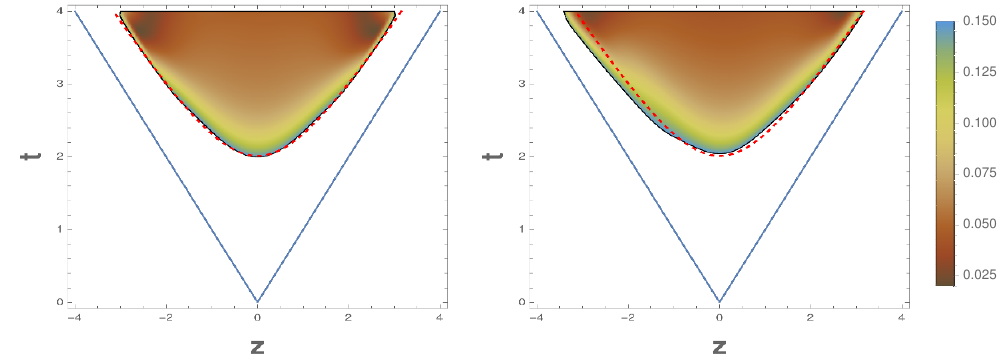
Figure 4 . The largest connected spacetime region 0 . 15 for a collision of narrow symmetric shocks, w ) = (0 . 1 , 0 . 25), on the right. The red dotted line shows the hyperbola ( t ( w + , w − with τ = 1 . 5. For both asymmetric and symmetric collisions the region